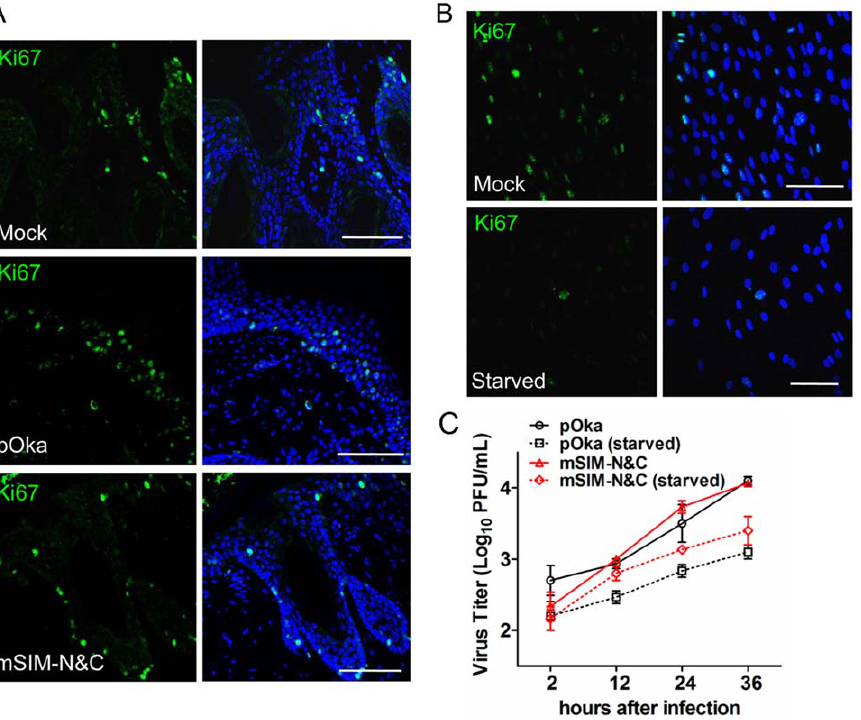
Figure 9. ORF61 SIMs are not required for VZV replication in non-proliferating cells invitro . (A) Confocal microscopy of mock-, pOka-, or pOka-mSIM-N&C-infected skin xenografts that were stained for the proliferation marker Ki67 (green) and nuclei (blue). Scale bars: 100 m m. (B) Confocal microscopy of normal and serum-starved HELFs that were stained for the proliferation marker Ki67 (green) and nuclei (blue). Scale bars: 100 m m. (C) Replication of pOka and pOka-mSIM-N&C in normal and serum-starved HELFs. Each point represents mean 6 SEM of virus titers from three replicates for each virus under normal and serum-starved conditions.